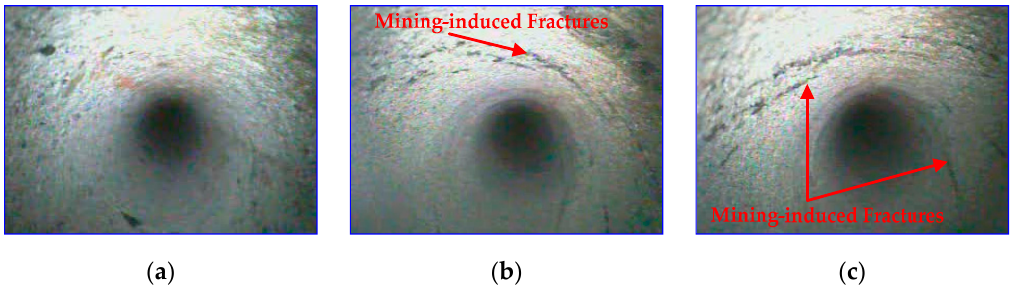
Figure 14. Images of the overburden around #3 characteristic point: ( a ) 100 m from the coalface; ( b ) 30 m from the coalface; ( c ) 20 m from the coalface.